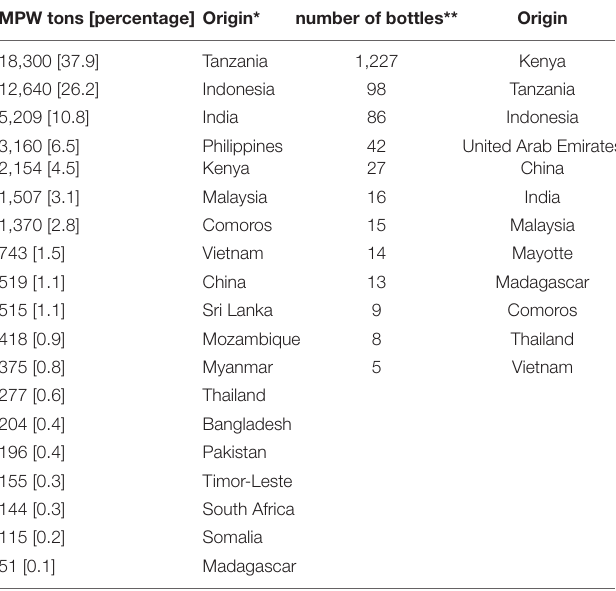
TABLE 2 | Origin of the modeled MPW found along the Kenyan coast, a total of 48,304 tons, along with the list of country/origin of the bottles that were found during the National Marine Litter Data Collection Training in August 13–22, 2019 (Ryan,